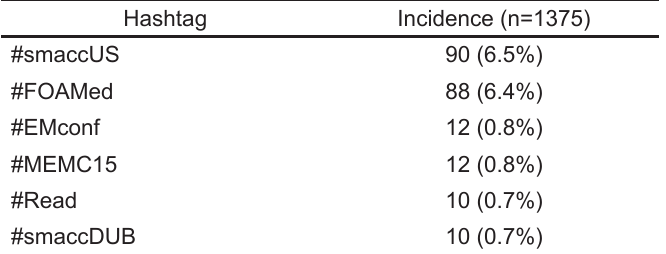
Table 1. Most commonly used hashtags among tweets of influential emergency